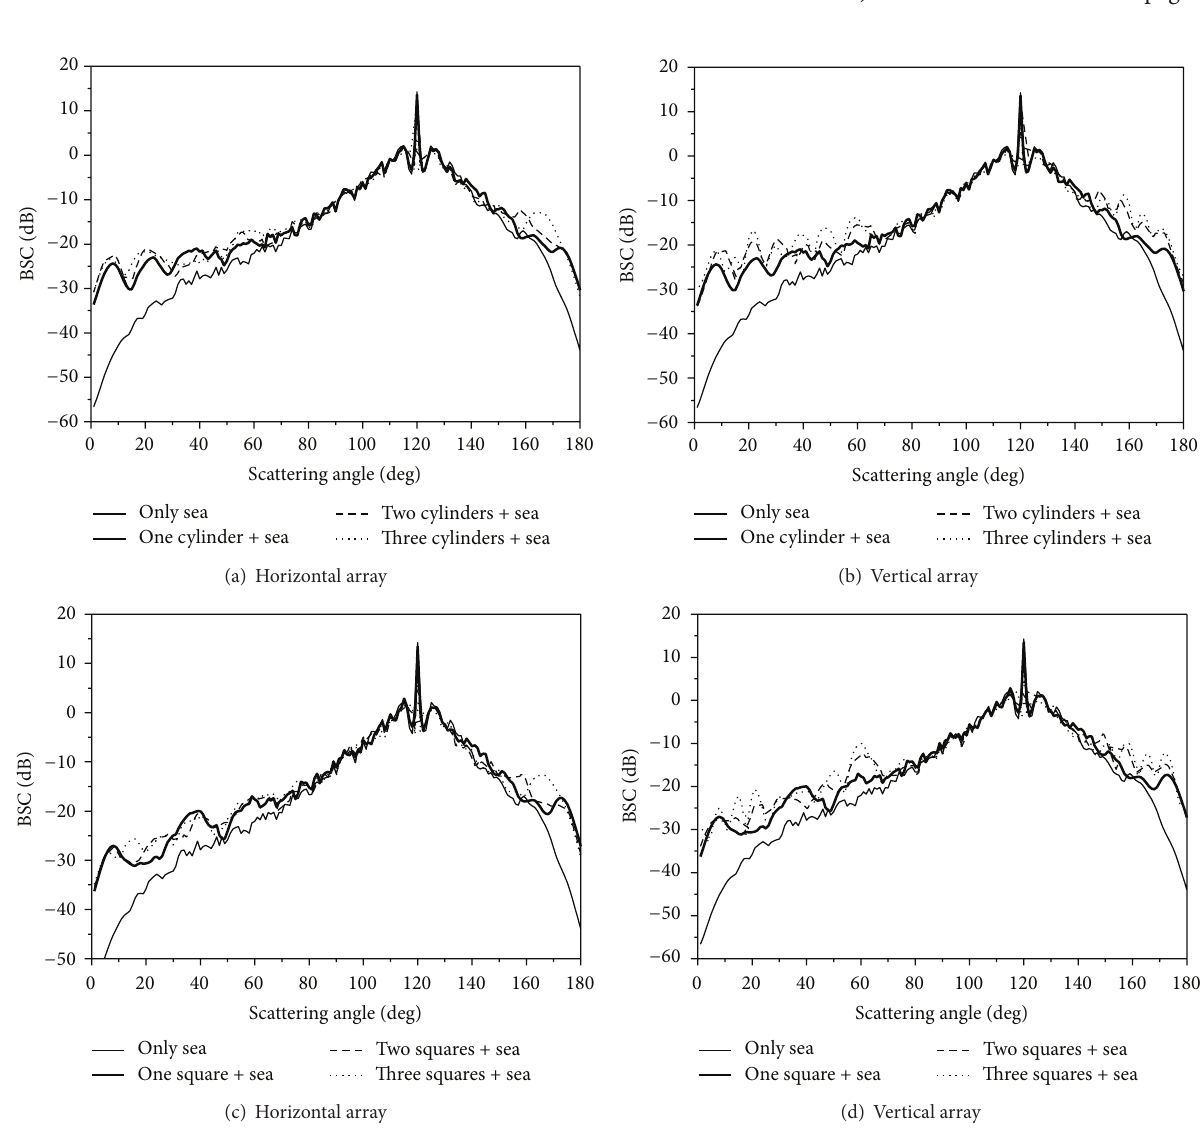
Figure 5: BSC of objects of different number over the PM rough sea surface.